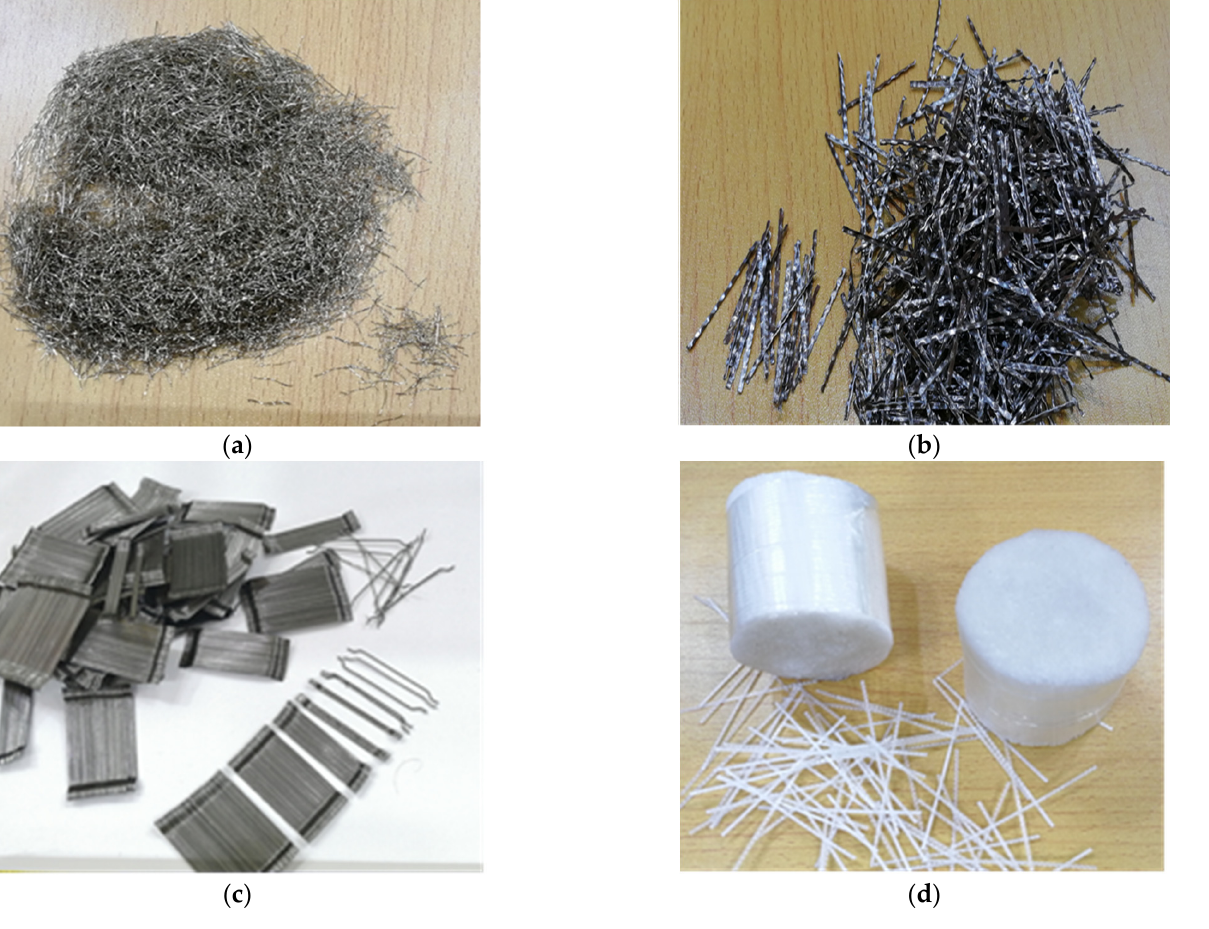
Figure 2. Types of fibers: ( a ) Straight steel fiber; ( b ) Corrugated steel fiber; ( c ) Hooked steel fiber; ( d ) Polyolefin fiber.